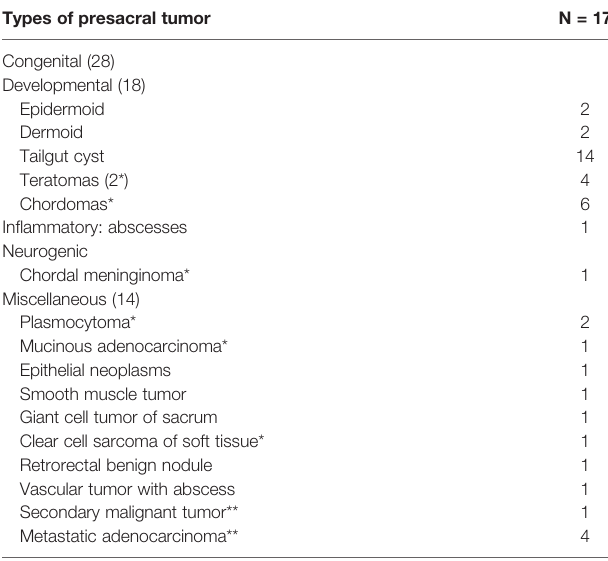
TABLE 3 | Tumor classi fi cation according to Uhlig and Johnson system (3). Types of presacral tumor